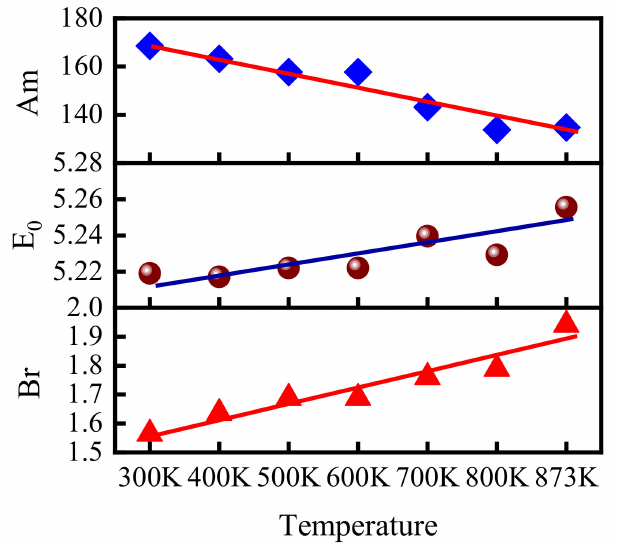
Figure 2. The temperature-dependent parameters of the Tauc–Lorentz oscillator which fits the ultraviolet-visible dielectric functions of Ta 2 O 5 thin films measured using an RC2